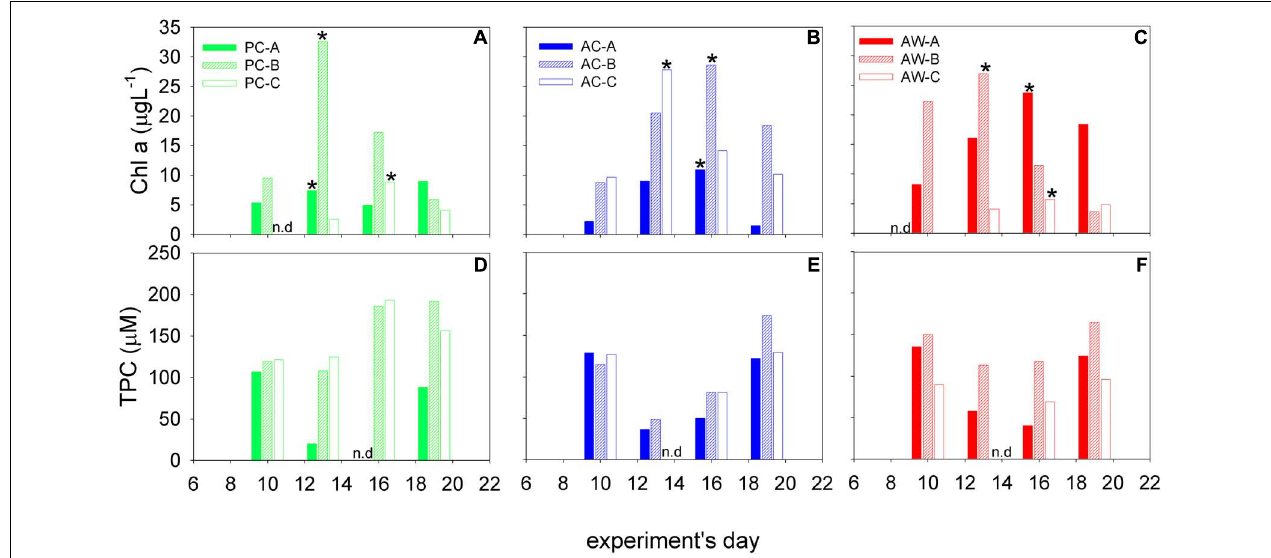
FIGURE 2 | Chl-a (A–C) and TPC (D–F) concentrations in the mesocosms at the time each roller tank aggregation experiment was started. Black star indicates the “bloom peak” in each mesocosm. Triplicate mesocosms were run for each of the three treatments: present CO 2 -cooler (PC, green), acidified-cooler (AC, blue), and acidified-warmer (AW, red); n.d., no